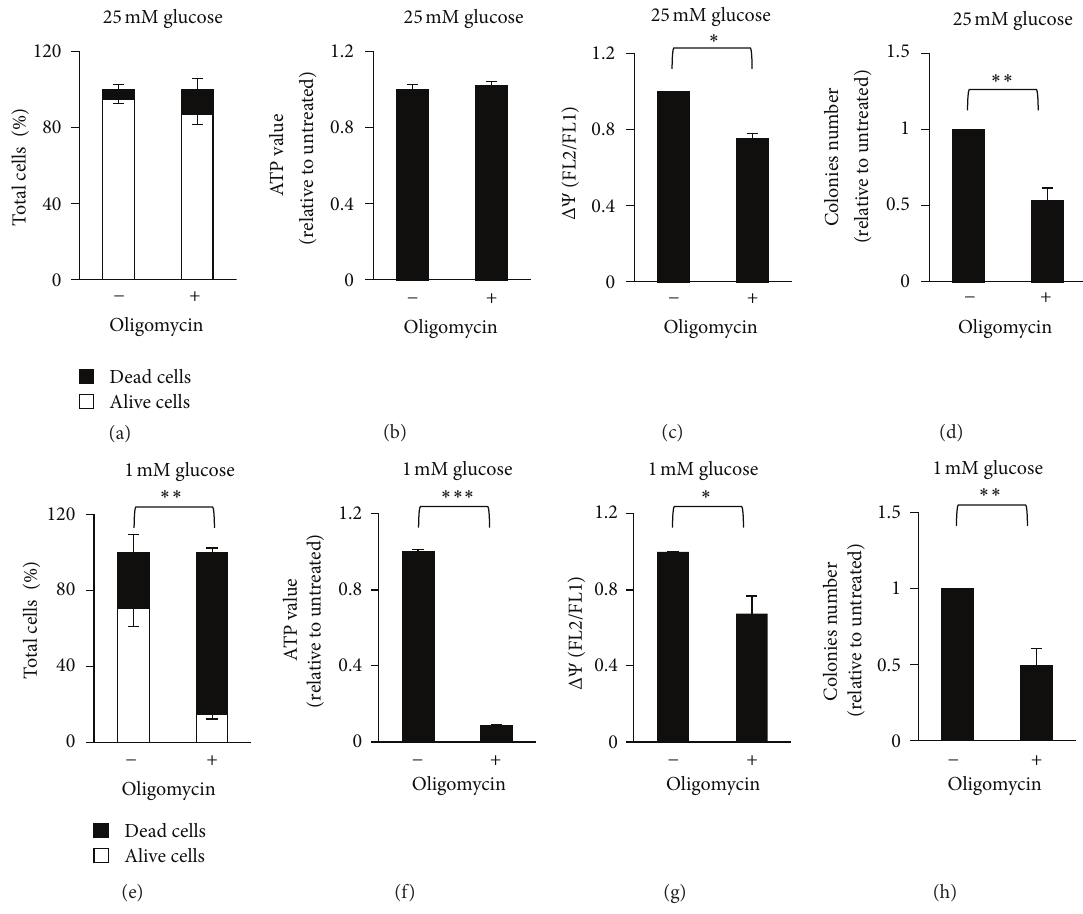
Figure 7: Oligomycin treatment induces a decrease of MDA-MB-231 cell viability especially in low glucose growth. MDA-MB-231 cells were cultured in (a)–(d) 25 mM and (e)–(h) 1mM glucose and treated for 1 hour with 5 𝜇 M oligomycin at 48 hours of culture. After treatment different parameters were investigated in untreated ( − ) and treated (+) cells: viable cell count by (a), (e) Trypan Blue Staining, (b), (f) intracellular ATP levels, and (c), (g) mitochondrial potential. After treatment 3 × 10 3 cells were also plated in normal growth medium for clonogenic assay and after ≥ 12 days colonies were stained and counted (d), (h). All data represent the average of at least three independent experiments ( ± s.d.); ∗ 𝑃 < 0.05 , ∗∗ 𝑃 < 0.01 , ∗∗∗ 𝑃 < 0.001 (Student’s 𝑡